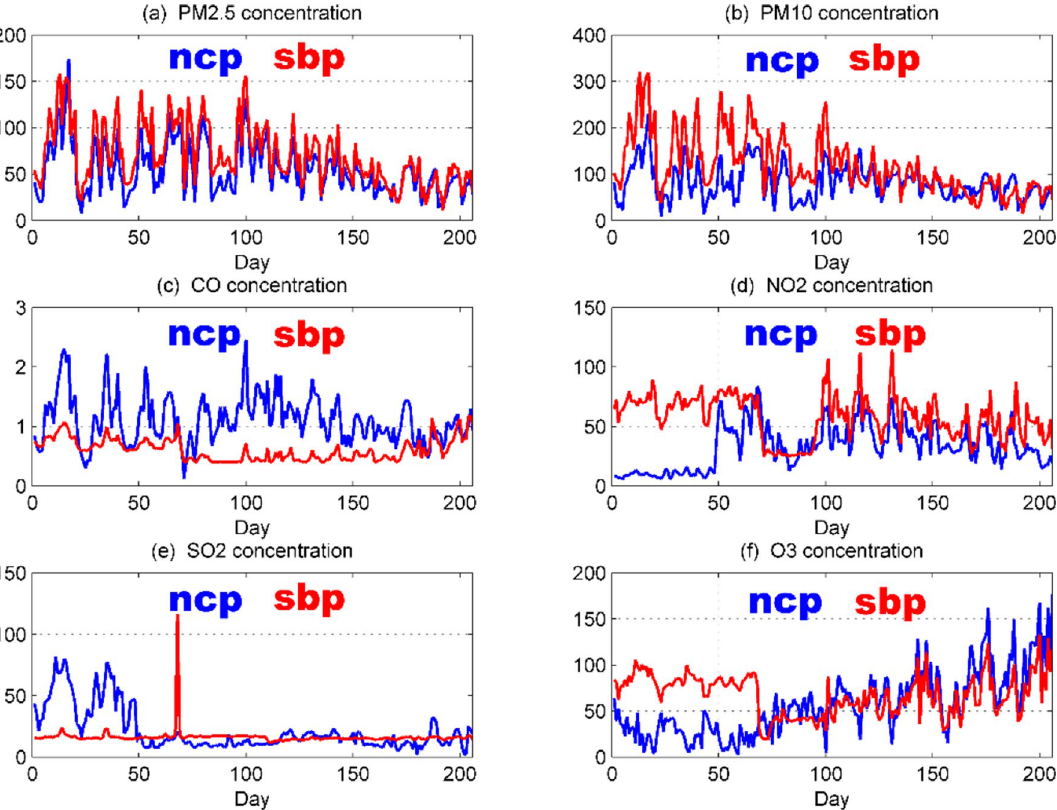
Figure 1. Comparison of daily average data of six types of pollutants at national control points and self-built